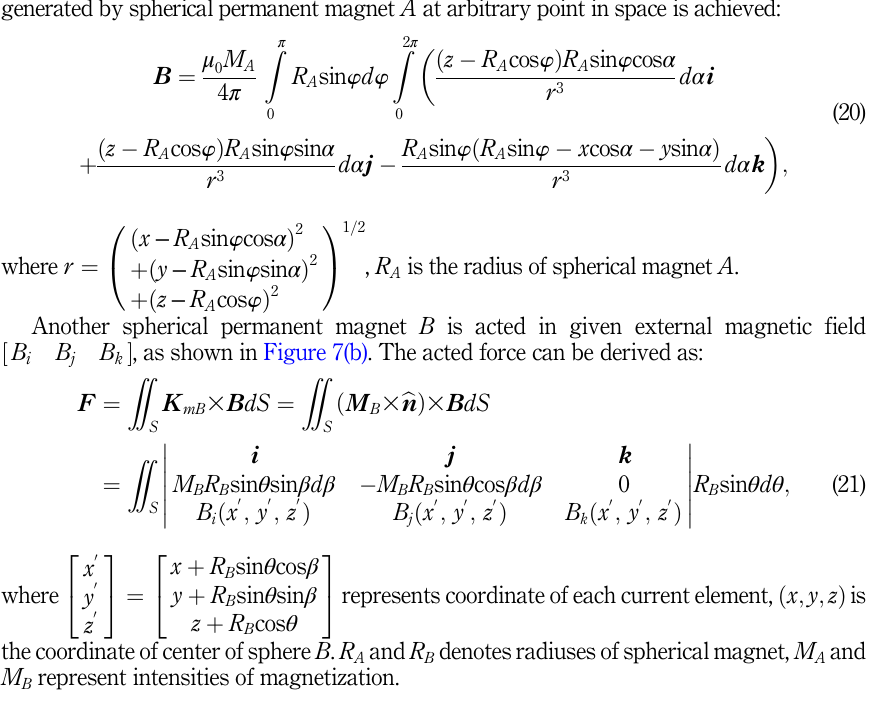
Figure 7. The positions of surface magnetizing currents on spherical permanent magnet in coordinate system. (a) producing magnetic field, (b) acted magnetic